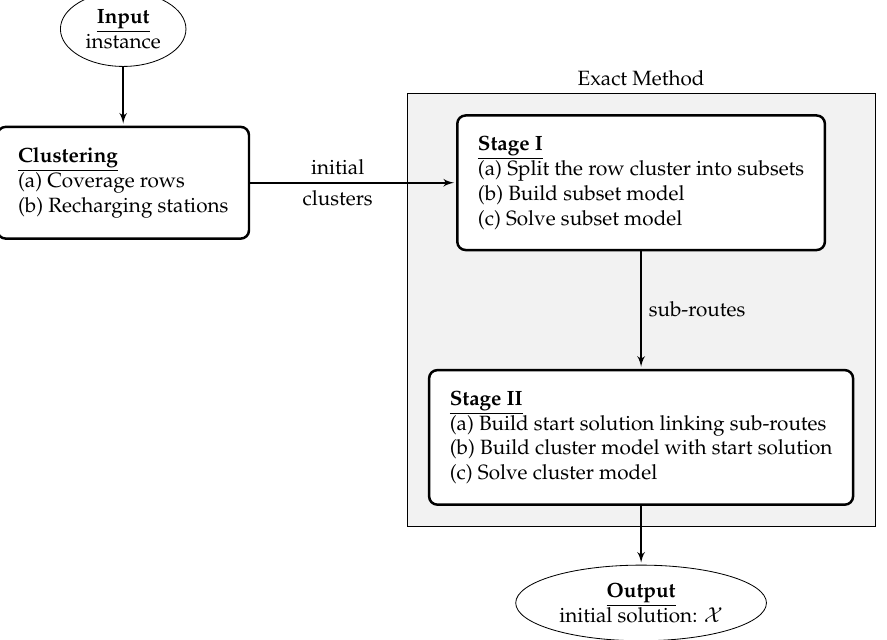
Figure 2. Scheme of the methods used in